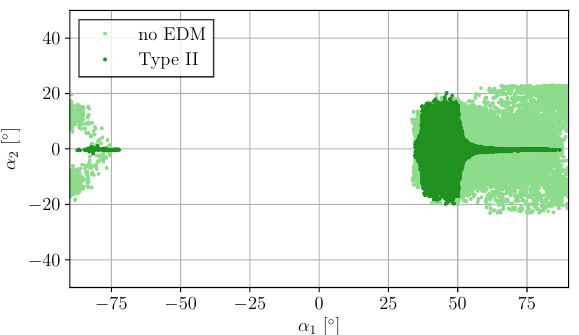
Figure 2 . Type II, H for sample 1 (dark) and sample 2